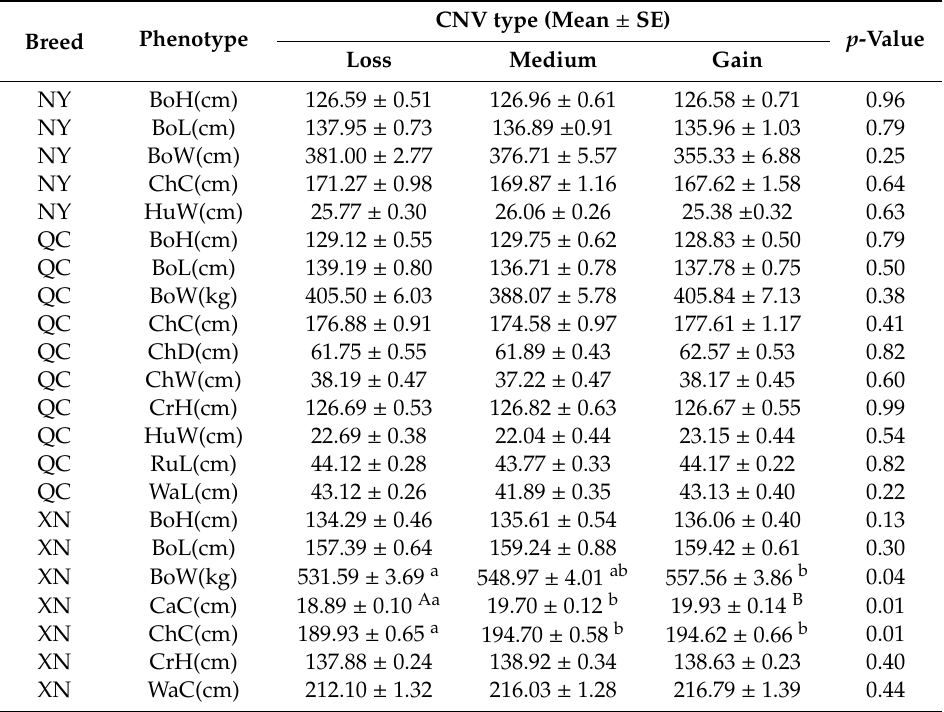
Table 3. Association results of one-way ANOVA for phenotypes of NY, QC and XN cattle.